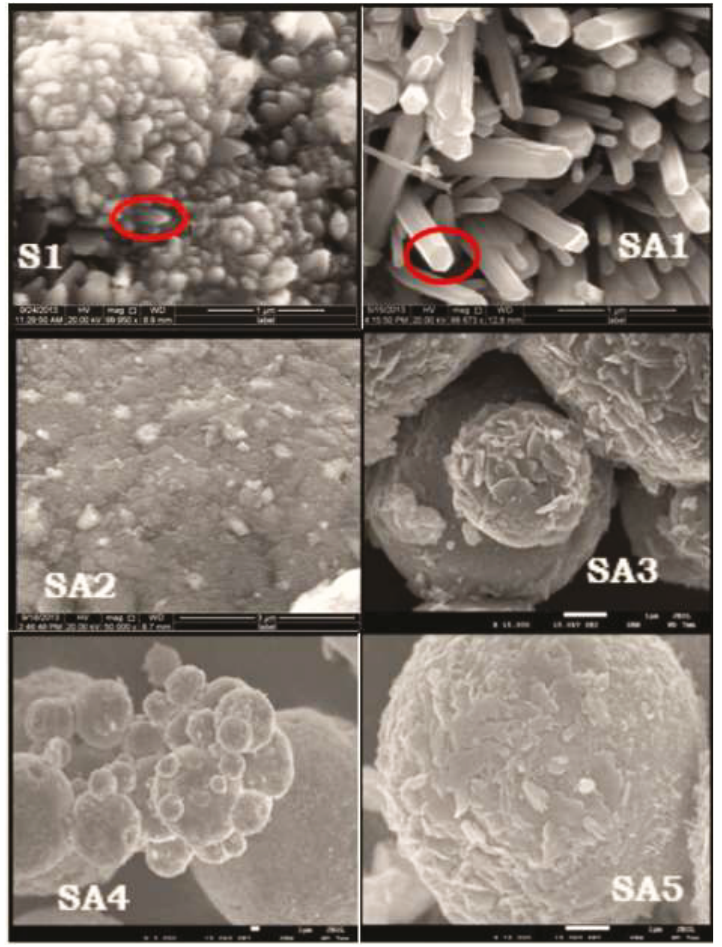
Figure 2: Scanning electron microscope spectroscopy images (S1: zero sample, SA1: conventional heating; SA2, SA3, SA4, and SA5 samples with assisted microwave technique).